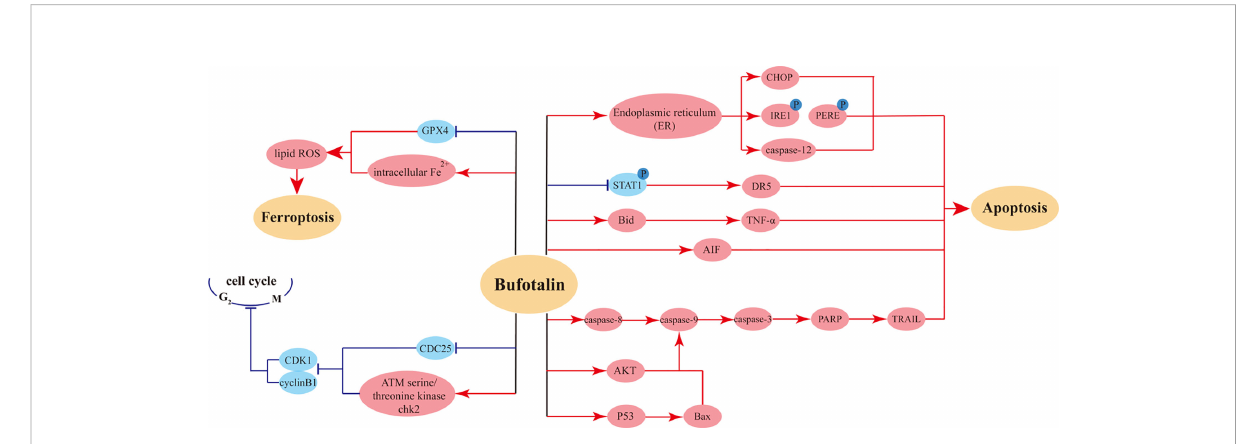
FIGURE 3 The primary mechanisms for bufotalin induced anti-tumor